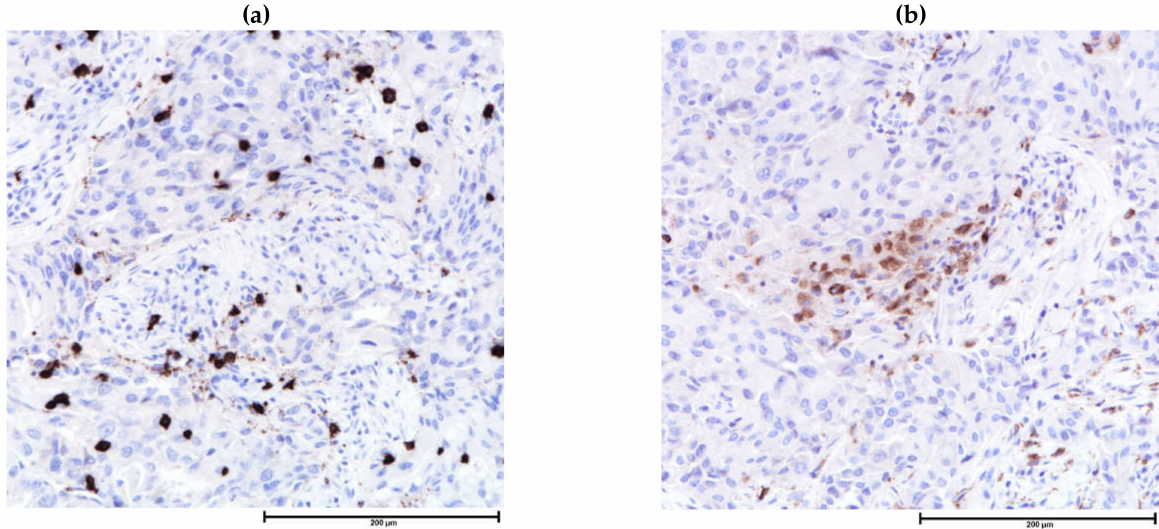
Figure 4. Immunohistochemistry for immune cells in the tumor microenvironment. ( a ) CD8 stain highlights cytotoxic T-cells among lymphocytes, CD8, 200 × ; ( b ) CD68 highlights tumor associated macrophages which are difficult to identify by H&E, CD68, 200 ×